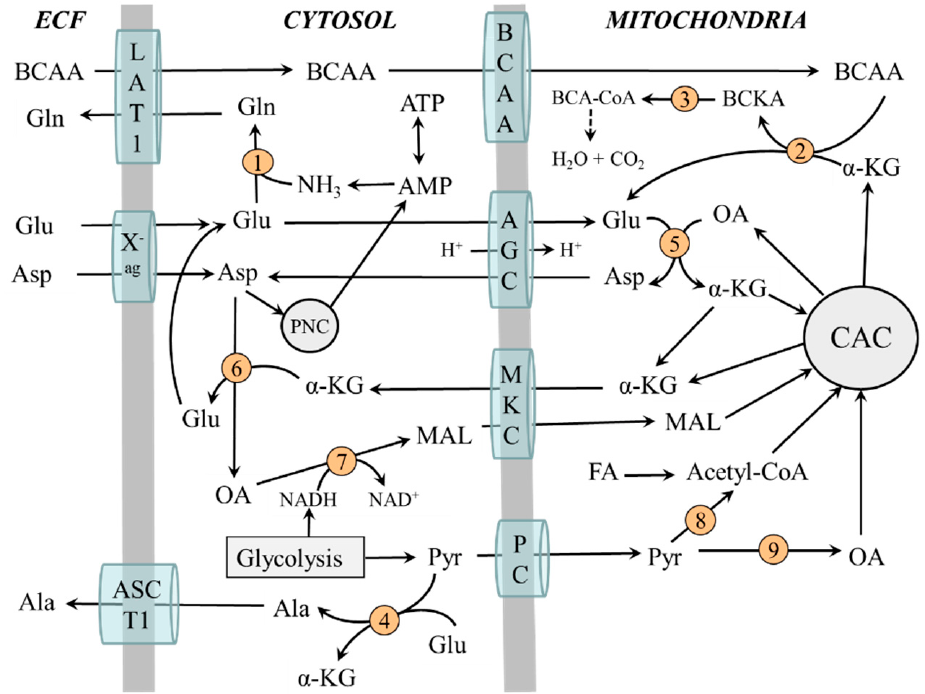
Figure 3. Compartmentation of ammonia and amino acid metabolism in muscles. 1, glutamine synthetase; 2, BCAA aminotransferase; 3, BCKA dehydrogenase; 4, ALT; 5, mitochondrial AST; 6, cytosolic AST; 7, malate dehydrogenase; 8, pyruvate dehydrogenase; 9, pyruvate carboxylase. AGC, aspartate-glutamate carrier; ASCT1 (alanine, serine, cysteine, and threonine carrier 1); BCAA, branched-chain amino acids; BCA-CoA, branched-chain acyl-CoA; BCKA, branched-chain keto acids; CAC, citric acid cycle; LAT1 (large neutral amino acid transporter 1); MKC, malate-ketoglutarate carrier; OA, oxaloacetate; PC, pyruvate carrier; PNC, purine nucleotide cycle; X - ag , a transporter for aspartate and glutamate.